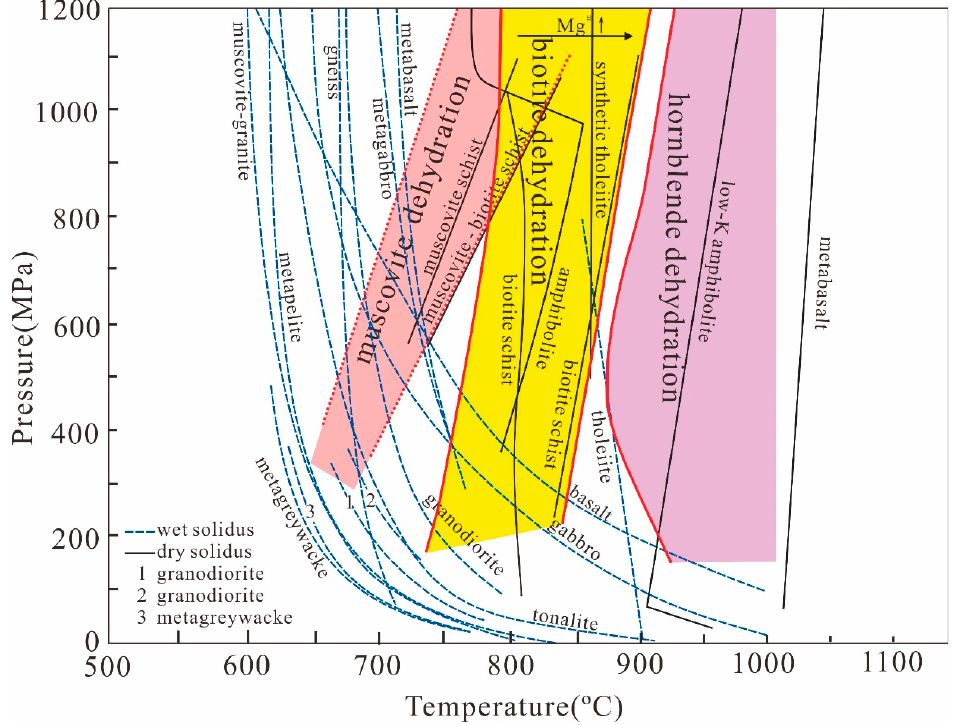
Figure 1. The representative dry or wet solidus curves of the crustal rocks and dehydration temperature of hydrous minerals, modified after the references [54,77–79].